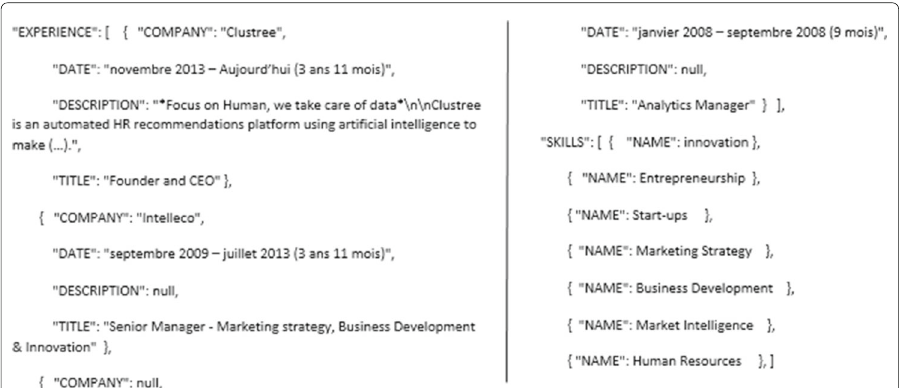
Fig. 4 An example of an output generated with the developed LinkedIn python